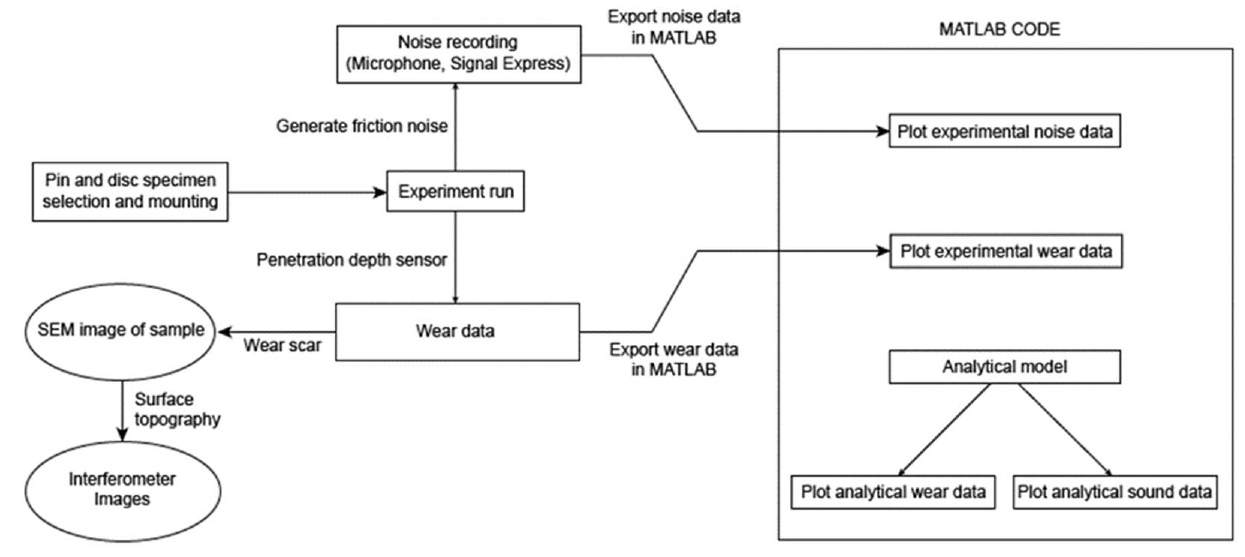
Figure 8. Flowchart of the experimental scheme.